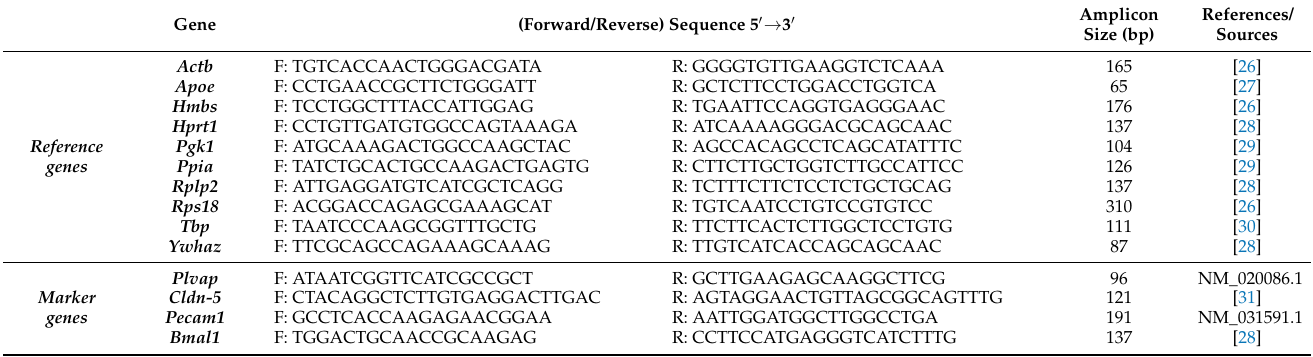
Table 1. Sequences of oligonucleotide primers used for qPCR